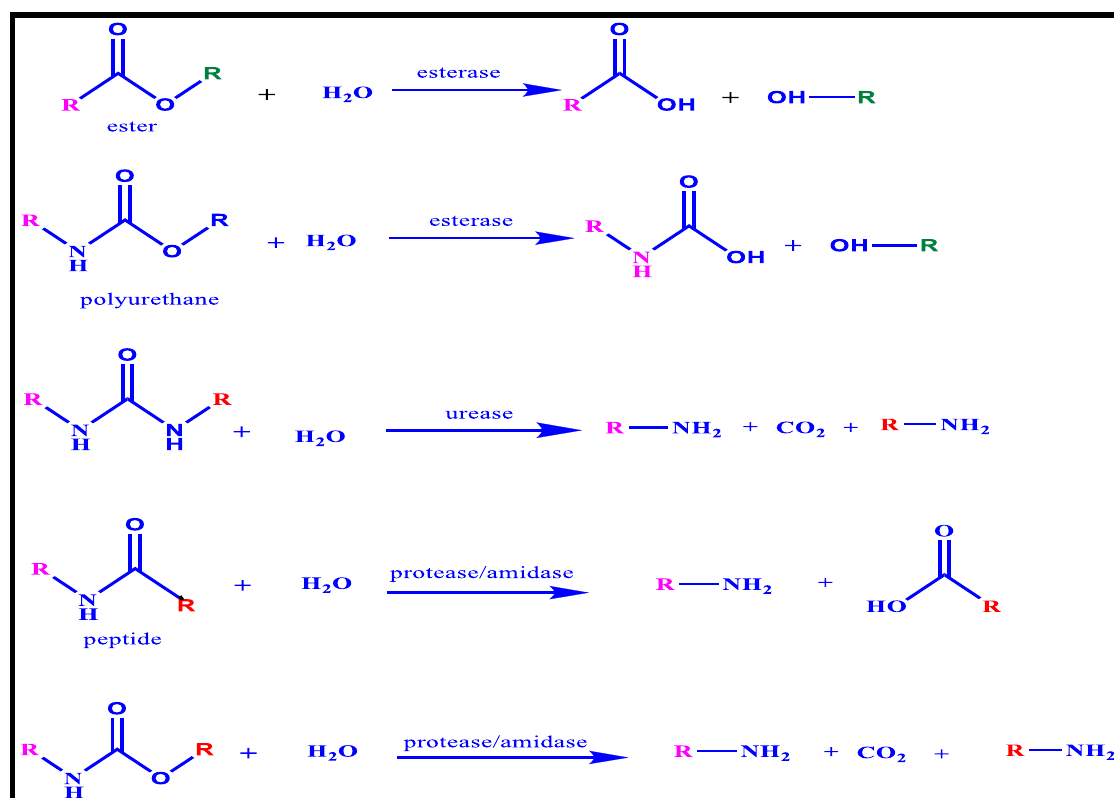
Figure 17. Enzymatic Degradation of Polyurethane.